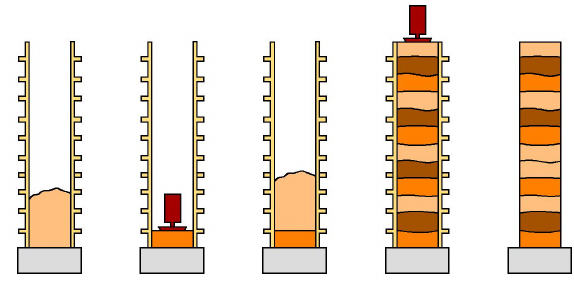
Figure 1. Process of making rammed earth specimen.